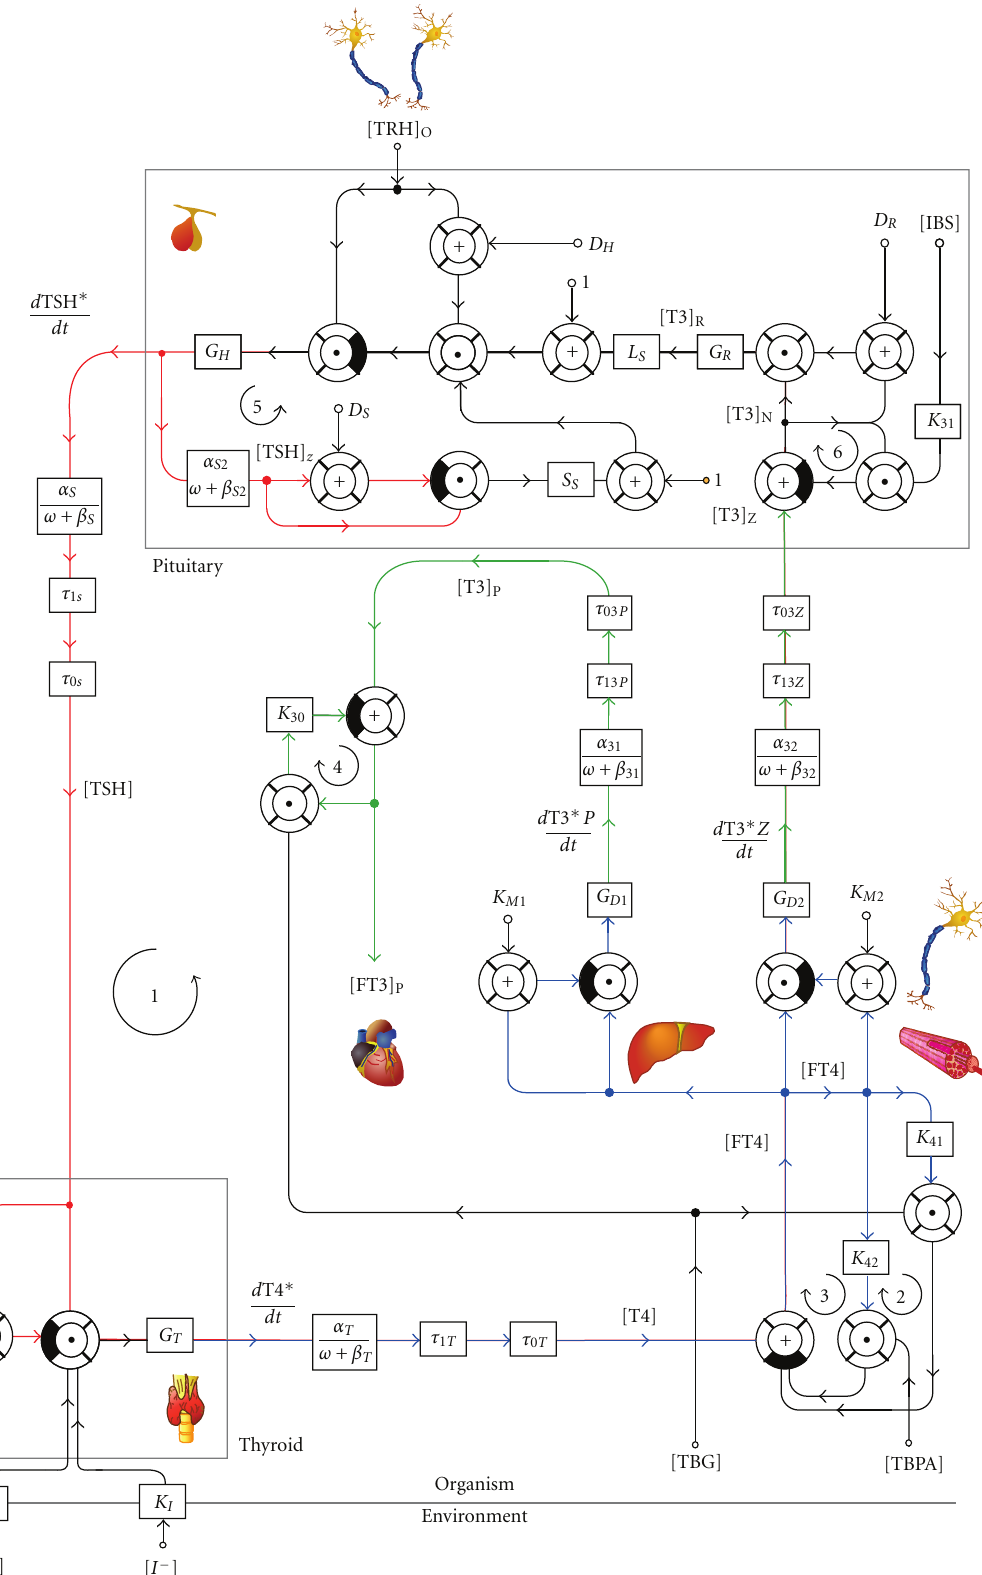
Figure 2: Information processing structure of a nonlinear parametrically isomorphic model based on Michaelis-Menten kinetics, noncompetitive divisive inhibition, and pharmacokinetic data [11]. Modified with permission from